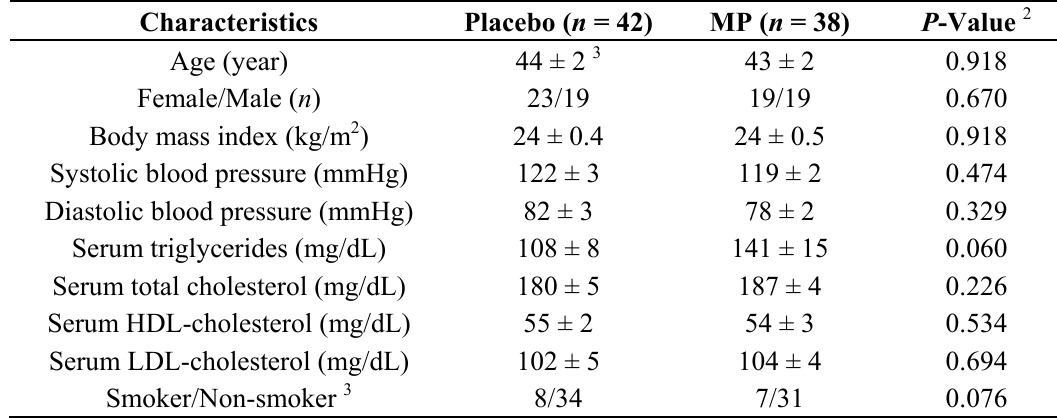
Table 1. Baseline characteristics of the subjects who completed the intervention trial 1 .